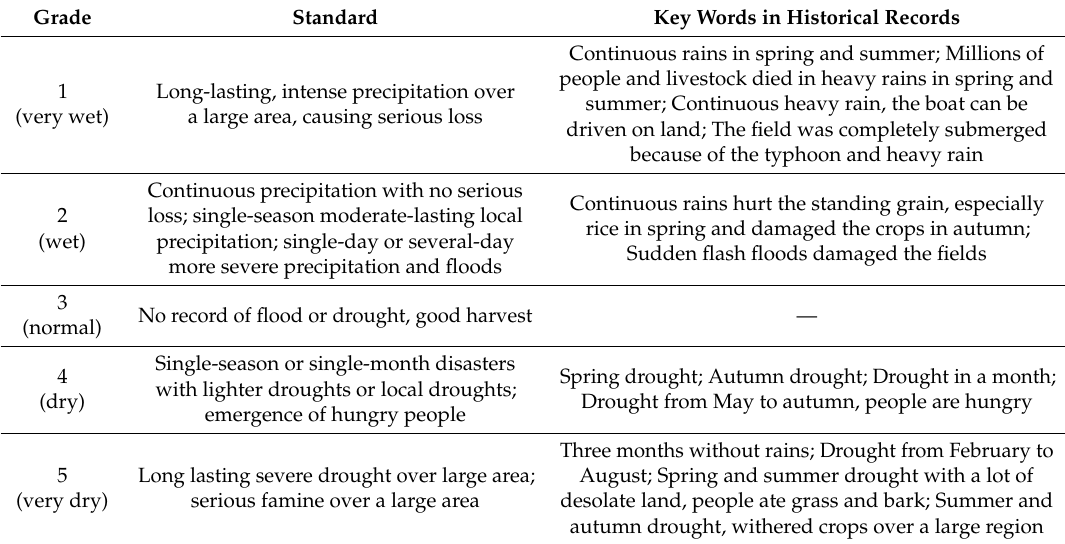
Table 1. Drought and flood classification from the historical description